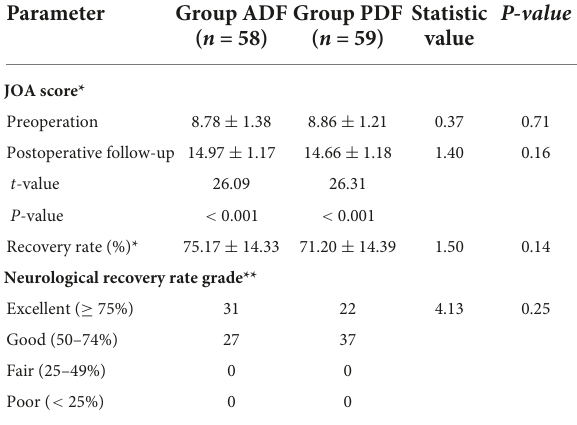
TABLE 2 PreOP and PostOP follow-up cervical radiological data in each group.